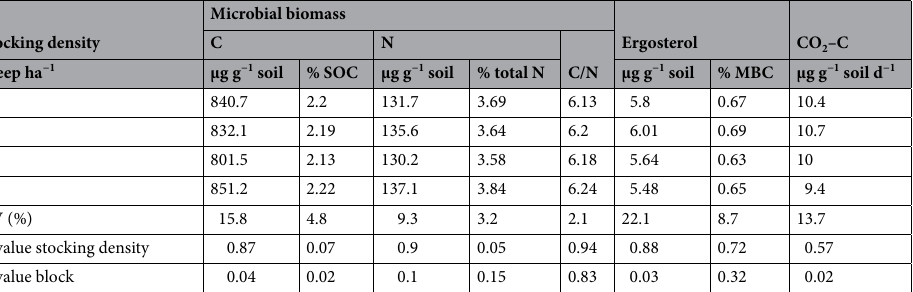
Table 3. Soil microbiological properties of a rangeland soil grazed by 0, 8, 16, and 24 sheep ha −1 in a two year grazing experiment from 2014–2015 on a summer pasture in the Chinese Altai Mountains, Qinghe, China.